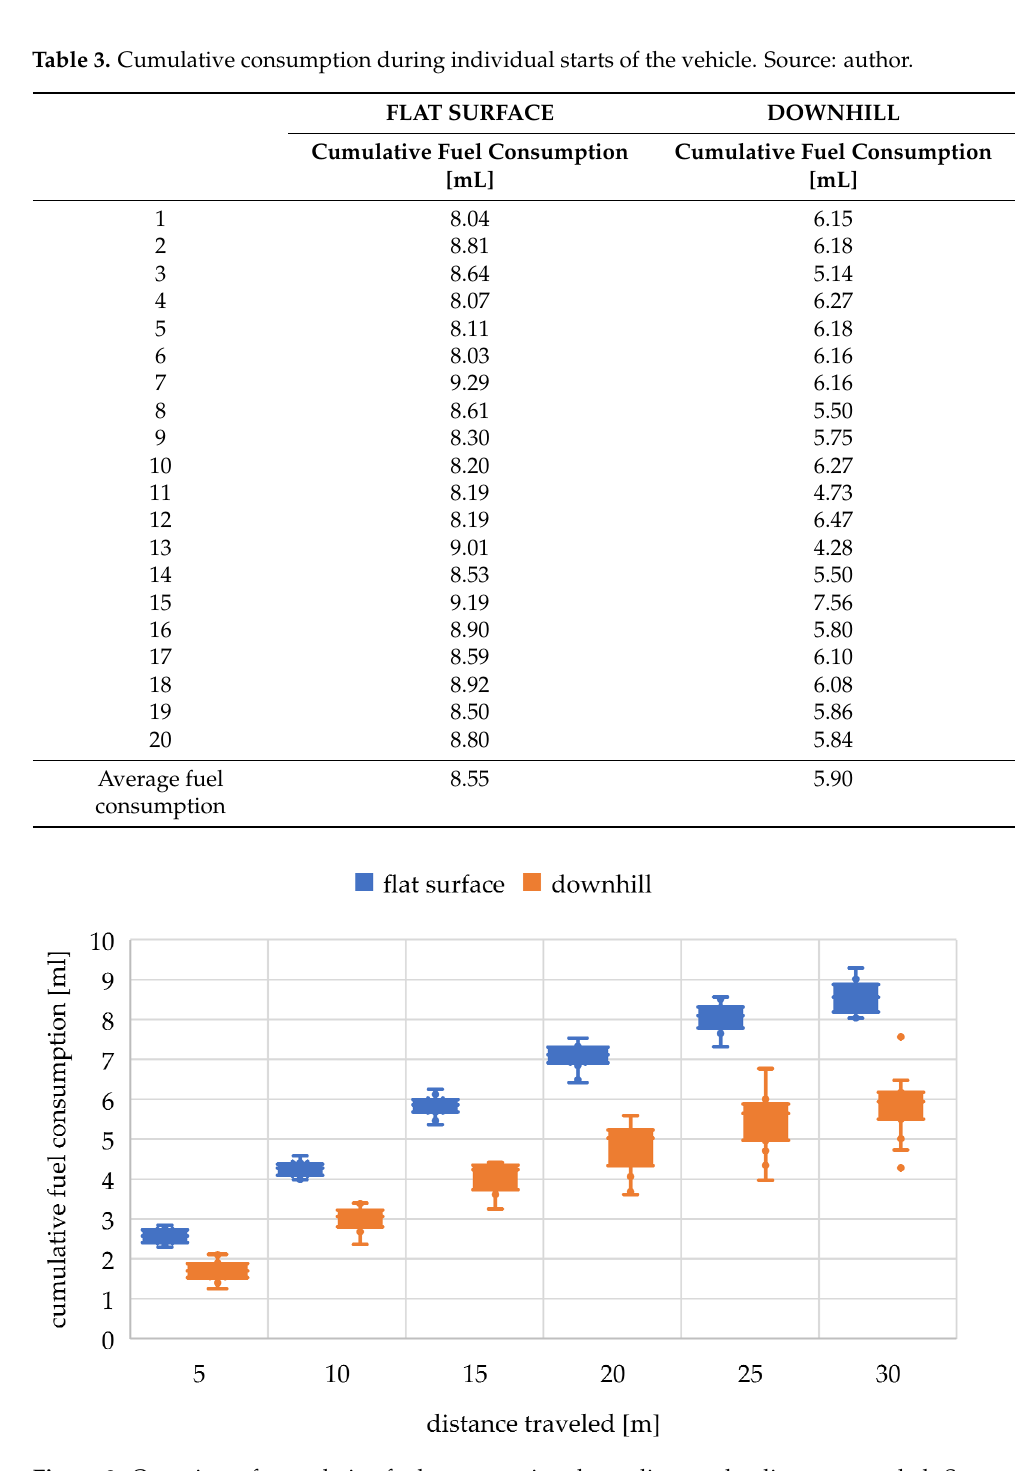
Table 3. Cumulative consumption during individual starts of the vehicle. Source: author. FLAT SURFACE